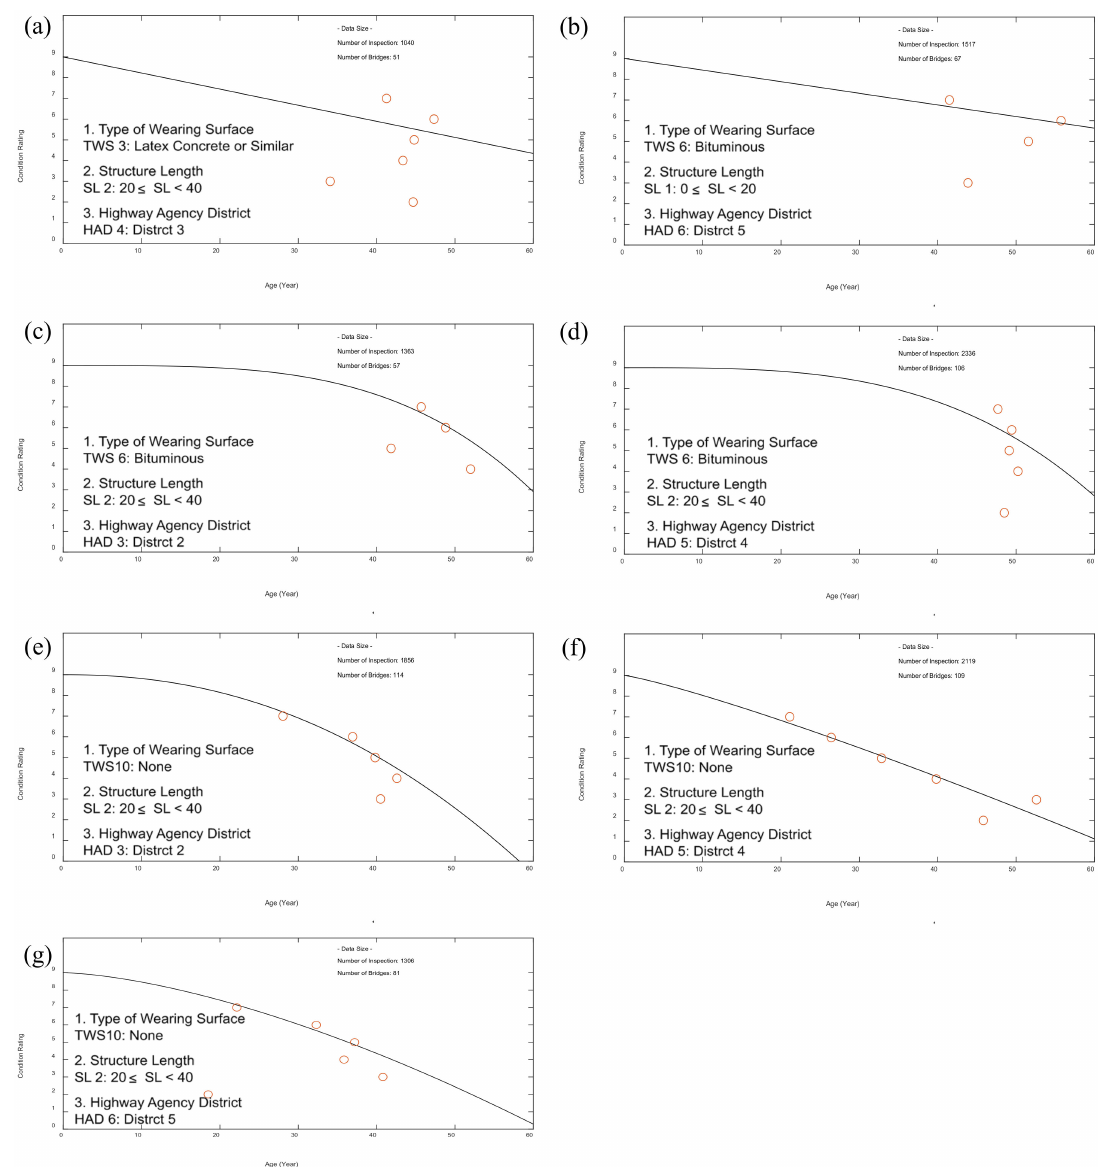
Figure 9. Deterministic deterioration models corresponding to the third level of the classification tree, for which the explanatory variables were identified using 2006-2013 National Bridge Inventory (NBI) data; ( a ) subset 1, ( b ) subset 2, ( c ) subset 3, ( d ) subset 4, ( e ) subset 5, ( f ) subset 6, and ( g ) subset